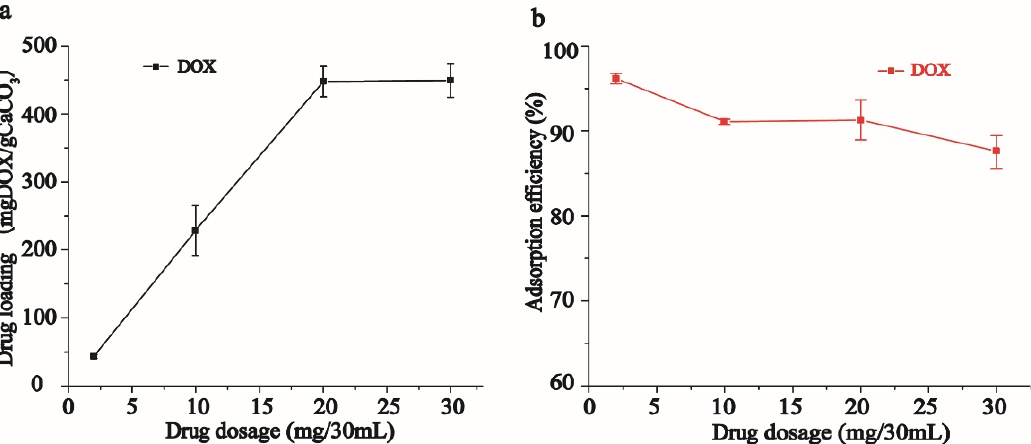
Figure 5. Effect of initial drug concentration on DOX adsorption. ( a ) Drug loading. ( b ) Efficiency of drug encapsulation.